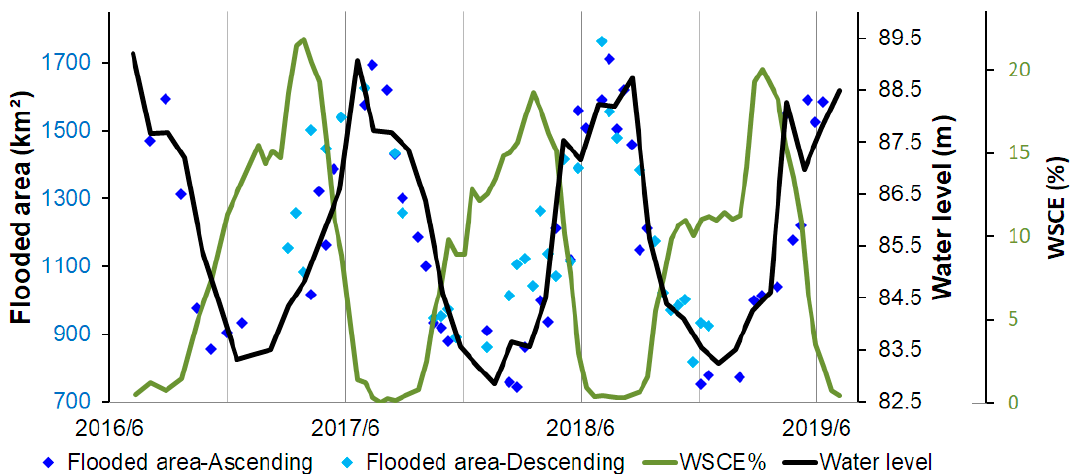
Figure 14. The internal cross-comparison of the Brahmaputra River’s flooded area detected by the ascending and descending imagery of Sentinel-1 and the comparisons with the time series water level estimated by Sentinel-3 altimetry and the Sentinel-1 SAR-based WSCE%.